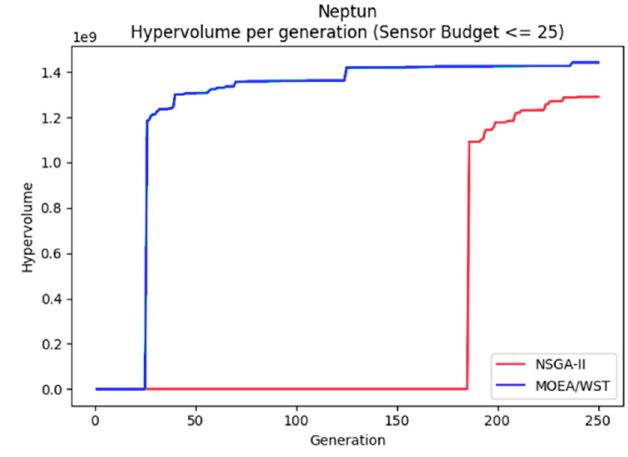
Figure 16. Hypervolume per generation.